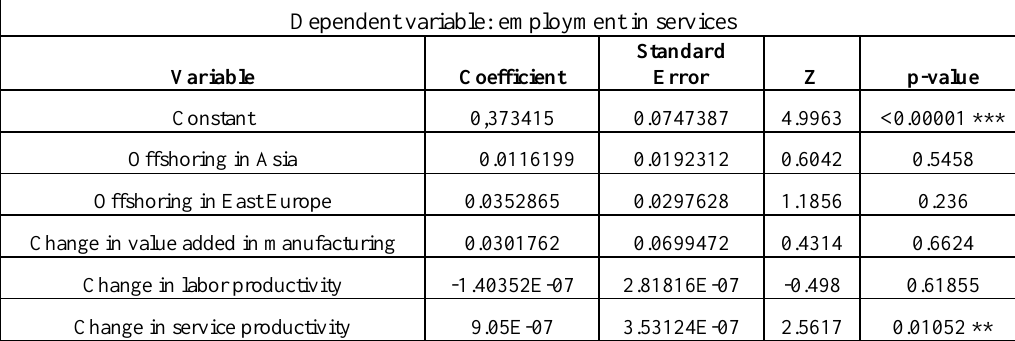
Table 9: Explaining Employment in Services in Italian Provinces 1999-2010 Dependent variable: employment in